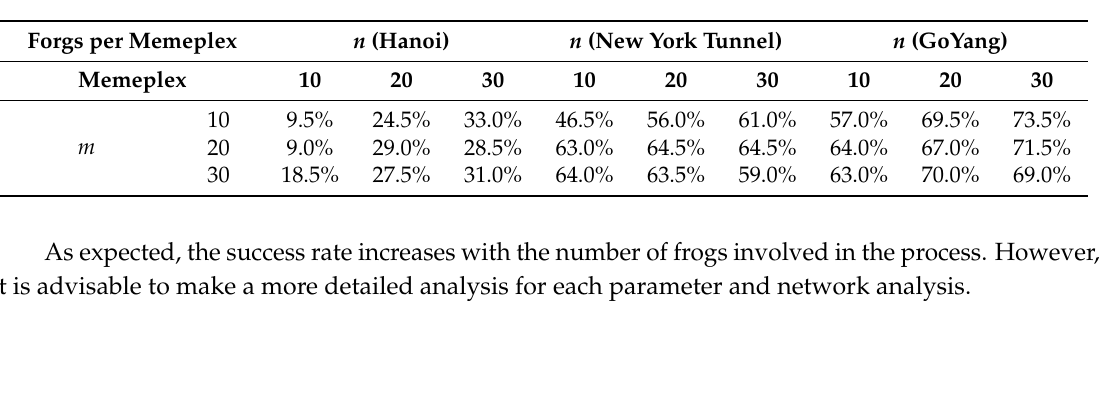
Table 3. Success rate obtained with P between 100 and 900 individuals.